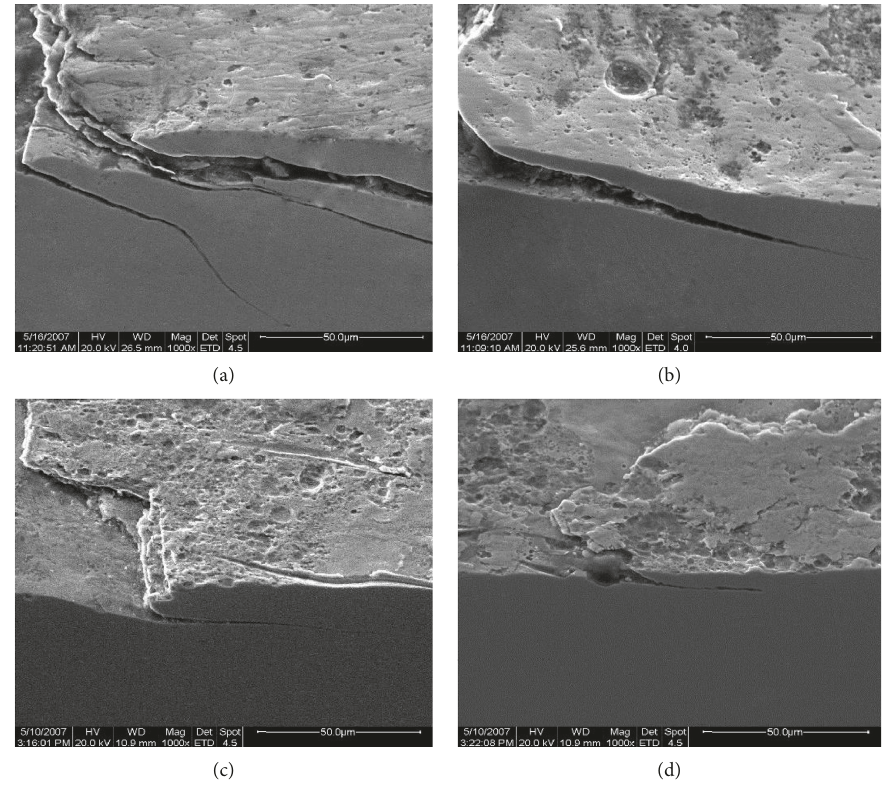
Figure 5: Crack growth of different rail material samples: (a) quenched PD3 rail (1000 × ); (b) hot-rolled PD3 rail (1000 × ); (c) quenched U71Mn rail (1000 × ); (d) hot-rolled U71Mn rail (1000 ×